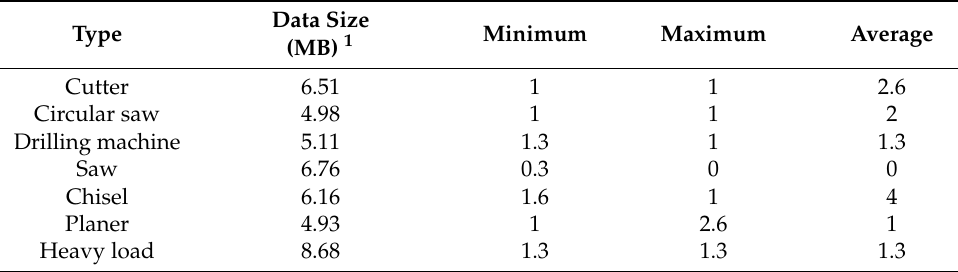
Table 17. Evaluation time required for each posture of